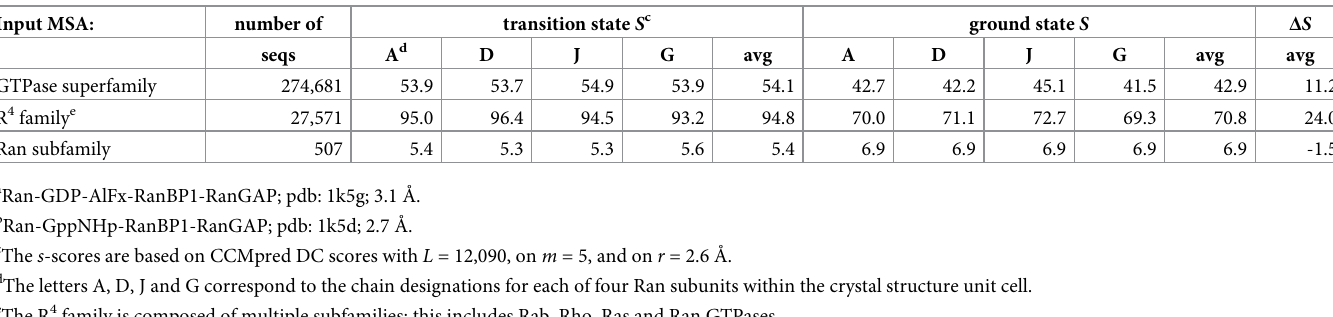
Table 4. S for Ran GTPase in the transition state complex a and in the corresponding ground state complex b